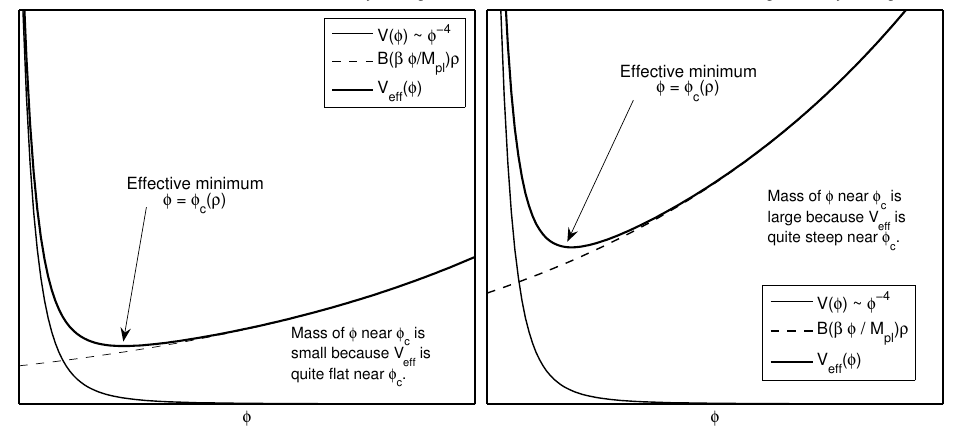
Figure 1. Chameleon mechanism for a runaway potential: V ∼ φ − 4 . The matter density is small in the left plot and it’s large in the right plot (see [30]). The mass of the chameleon is an increasing function of the background matter density. These plots can be found in